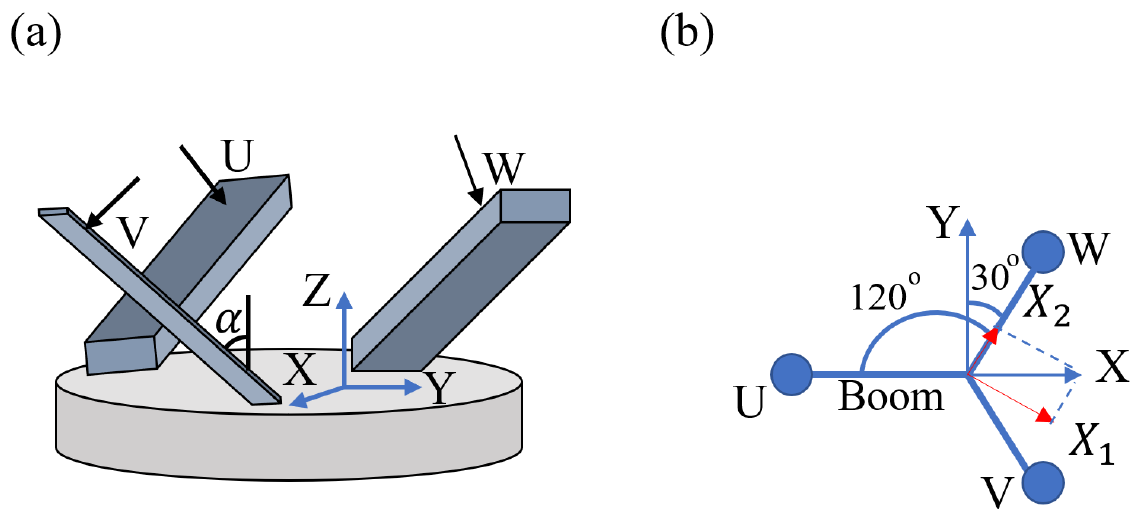
Figure 1. ( a ) The configuration of the triaxial seismometer used in the derivation. The UVW vectors are normal to the boom planes. The UVW axes are orthogonal only when the angle α is at the Galperin tilt angle, 35.26 deg. ( b ) The simplified top view of the UVW seismometer.